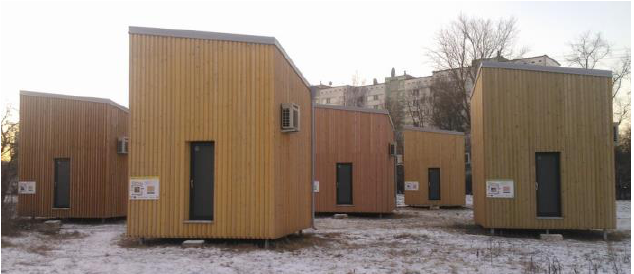
Fig. 1. Disposition of test stands.